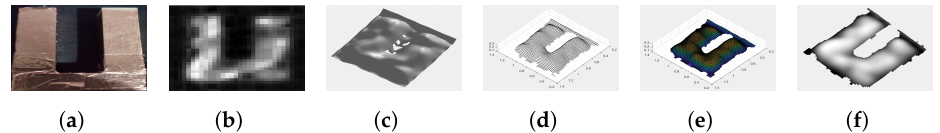
Figure 7. Three-dimensional (3D) reconstruction schematic: ( a ) original image of the object, ( b ) recon- structed 2D image obtained using the SPI NIR system prototype, ( c ) 3D SFS with imperfections, gaps and outliers in the surface, ( d ) 3D image obtained after filtering, ( e ) 3D mesh obtained after using the power crust algorithm, and ( f ) the final and improved 3D image with iToF.